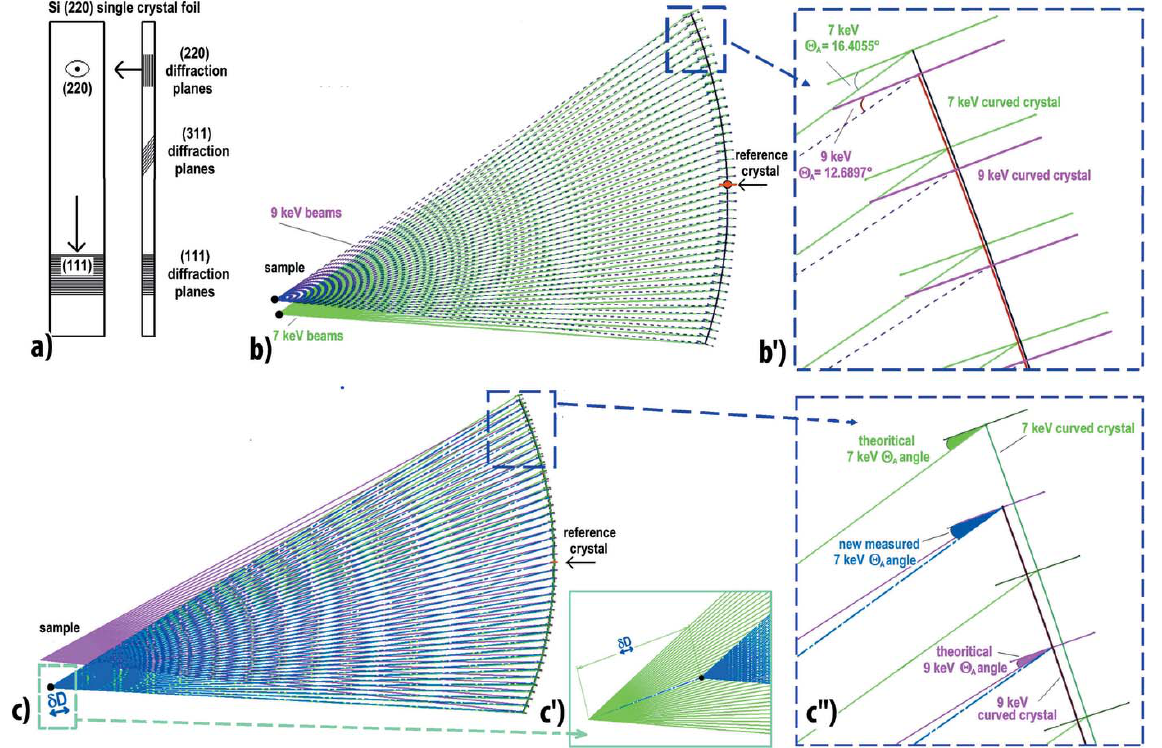
Figure 4 Optimization of the curvature of crystal sheets to realize Laue mode analysers; along its curvature, at every 1 (cid:3) , the diffraction planes of these thin curved crystals are symbolized by a large plane with the corresponding direction of its incident X-ray beam. ( a ) Examples of crystal plane orientations for positioning the thin Si single-crystal sheet in a transmission MAD system. ( b ) Beam paths from two sources at 7 keV and 9 keV (green and purple, respectively) arriving on the Si(111) planes of two single-crystal sheets which have ideal curvatures for 7 keVand 9 keV, respectively; the origins of these representations have been translated so that the midpoints of the two curved crystal sheets are coincident. ( b 0 ) Zoom-in on the directions and impacts of the beams at the upper ends of the single-crystal sheet which enlarge the most important curvature difference existing between 7 keVand 9 keV (green and purple), an energy range close to that of a Cu K (cid:2) 1 X-ray source. ( c ) Beam paths coming from these two different energy sources 7 keVand 9 keV, positioned to be filtered by Si(111) planes of a single-crystal sheet having its curvature determined for 9 keV in both cases; the purple curve represents the ideal paths of the 9 keV beams filtered by a MAD system having an ideal curvature for 9 keV, the blue curve represents the paths of the 7 keV beams filtered by a MAD system having a modified curvature corresponding to 9 keV filtering and corrected due to a (cid:4) D optimization of the sample-to-MAD- system distance. ( c 0 ) Enlargement showing this variation (cid:4) D in the distance of the sample from the MAD system which can modify and reduce the deviations of the Bragg angle (cid:2) A of the beams on this curved crystal of the MAD filter and can allow a wider angular range of filtering, as discussed in the text and in Fig. 5. ( c 00 ) Zoom-in on the impact of these 7 and 9 keV beams, at the upper ends of the single-crystal sheet with curvatures determined for 9 keV ideally and with the modification due to a small (cid:4) D variation of the sample-to-MAD-system